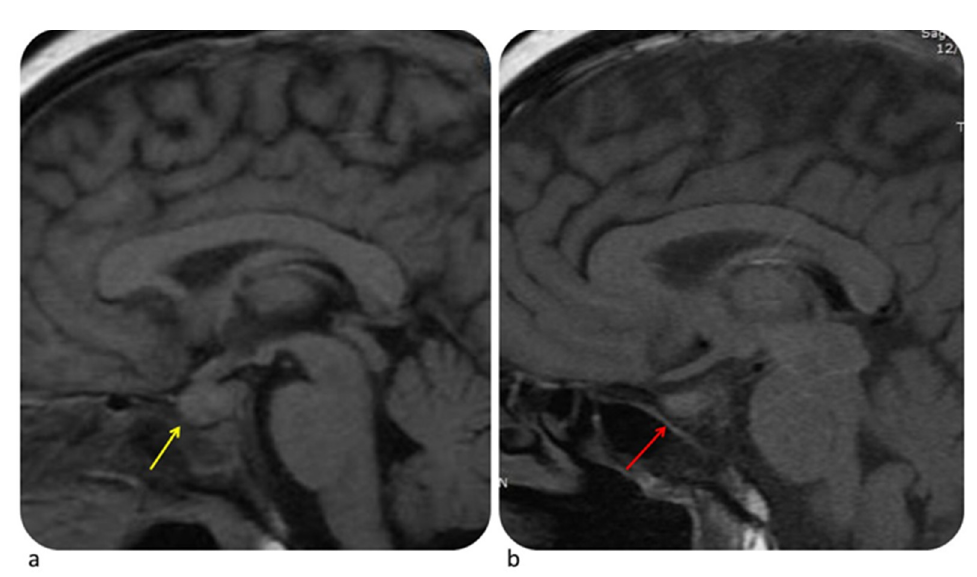
Figure 7. Hypophysitis in a 54-year-old woman with metastatic melanoma treated with ipilimumab. MRI performed at time of headache shows homogeneously enlarged pituitary gland ( a , yellow arrow). Ipilimumab was stopped and patient was given hormone replacement therapy. MRI obtained one month later shows decrease in size of pituitary gland ( b , red arrow). © Department of Neuroradiology, University of Pisa.